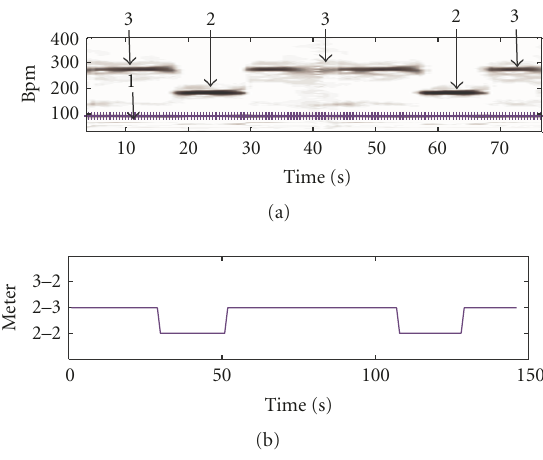
Figure 8: (a) tempo estimation over time (b) MBST estimation over time; on [signal: “Standard of excellence-accompaniment CD- Book2-All inst.-88. Looby